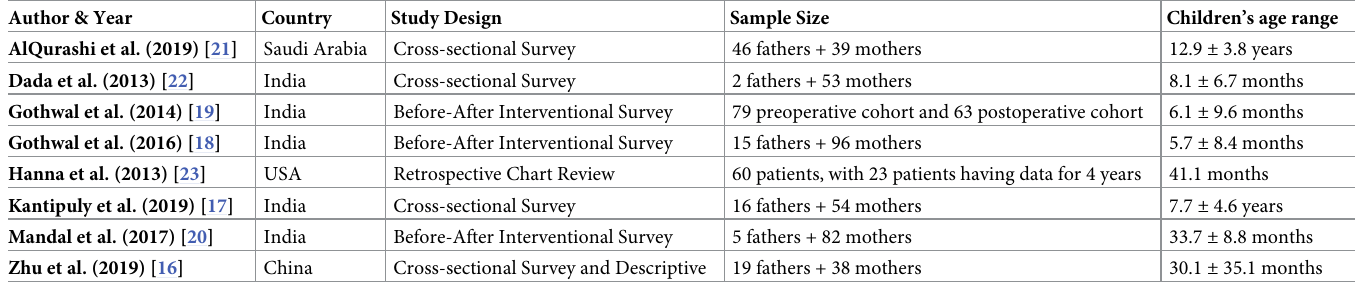
Table 1. Study characteristics of the included